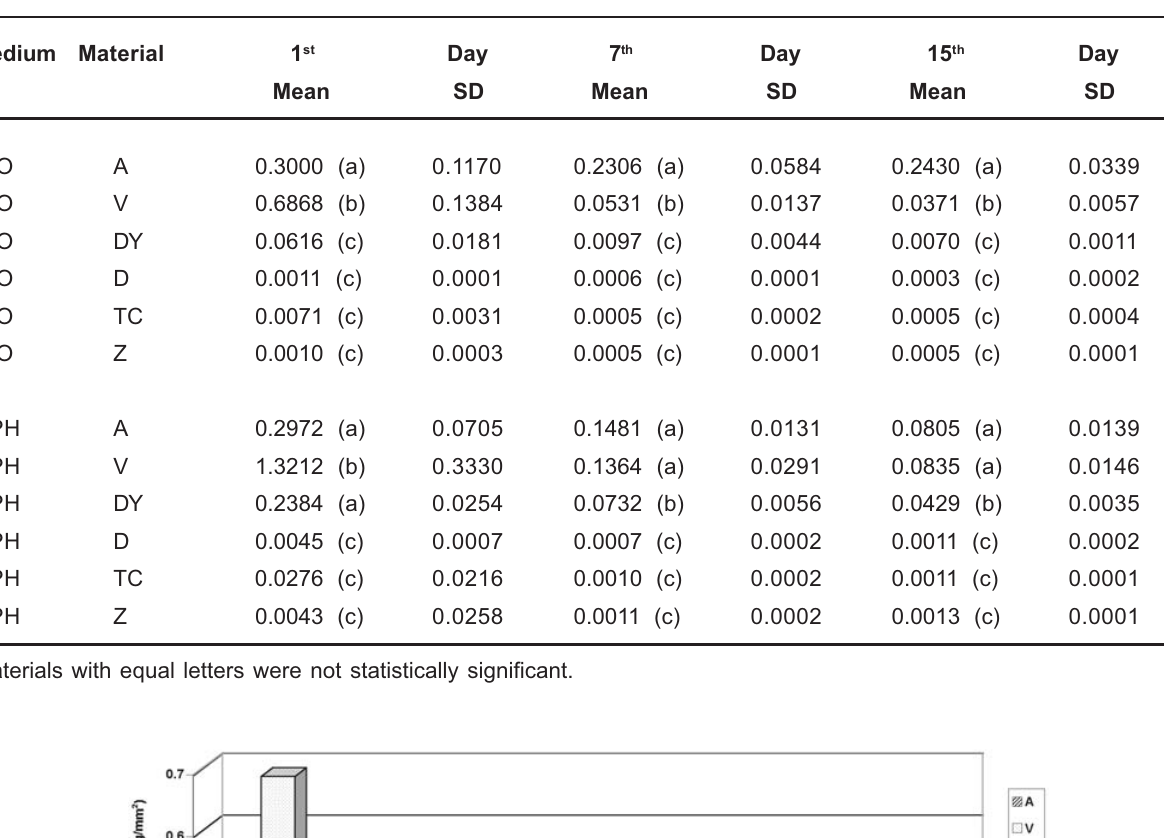
TABLE 2- Fluoride release means (µg/mm 2 ) and standard deviation of the restorative materials in H on the 1 st , 7 th and 15 th days